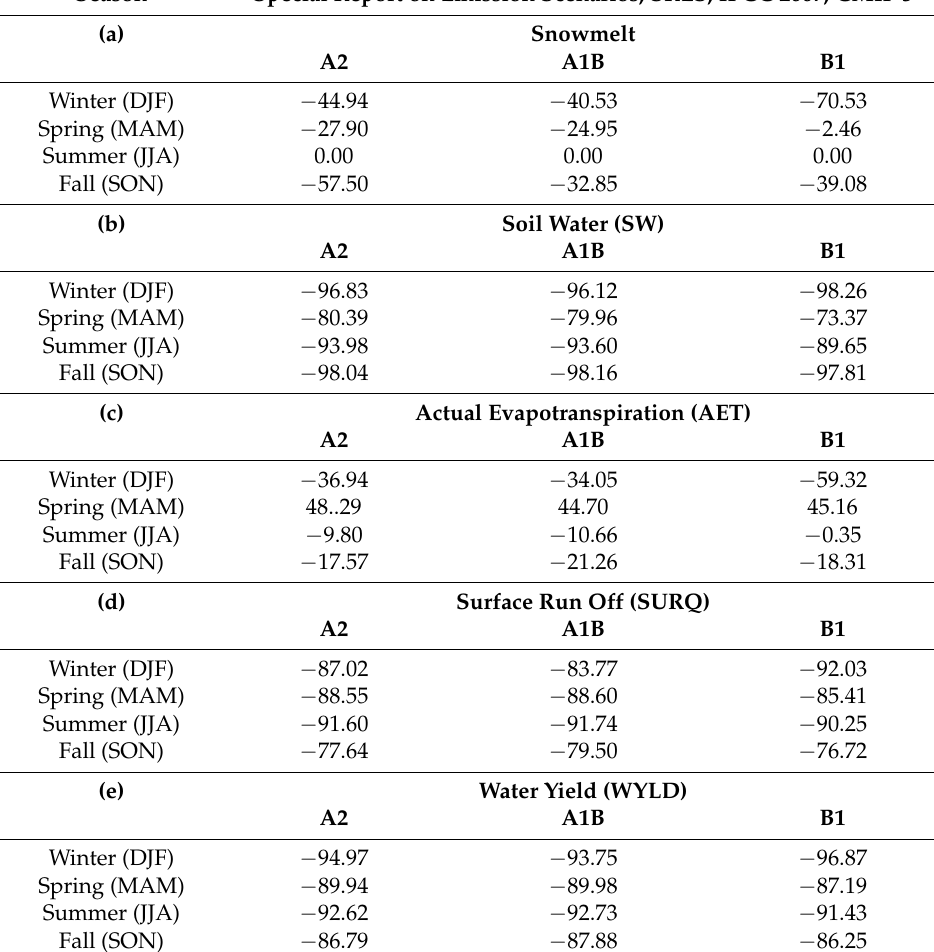
Table A4. Variation in different hydrologic components in percentage on seasonal basis compared to baseline in response to projected climate change